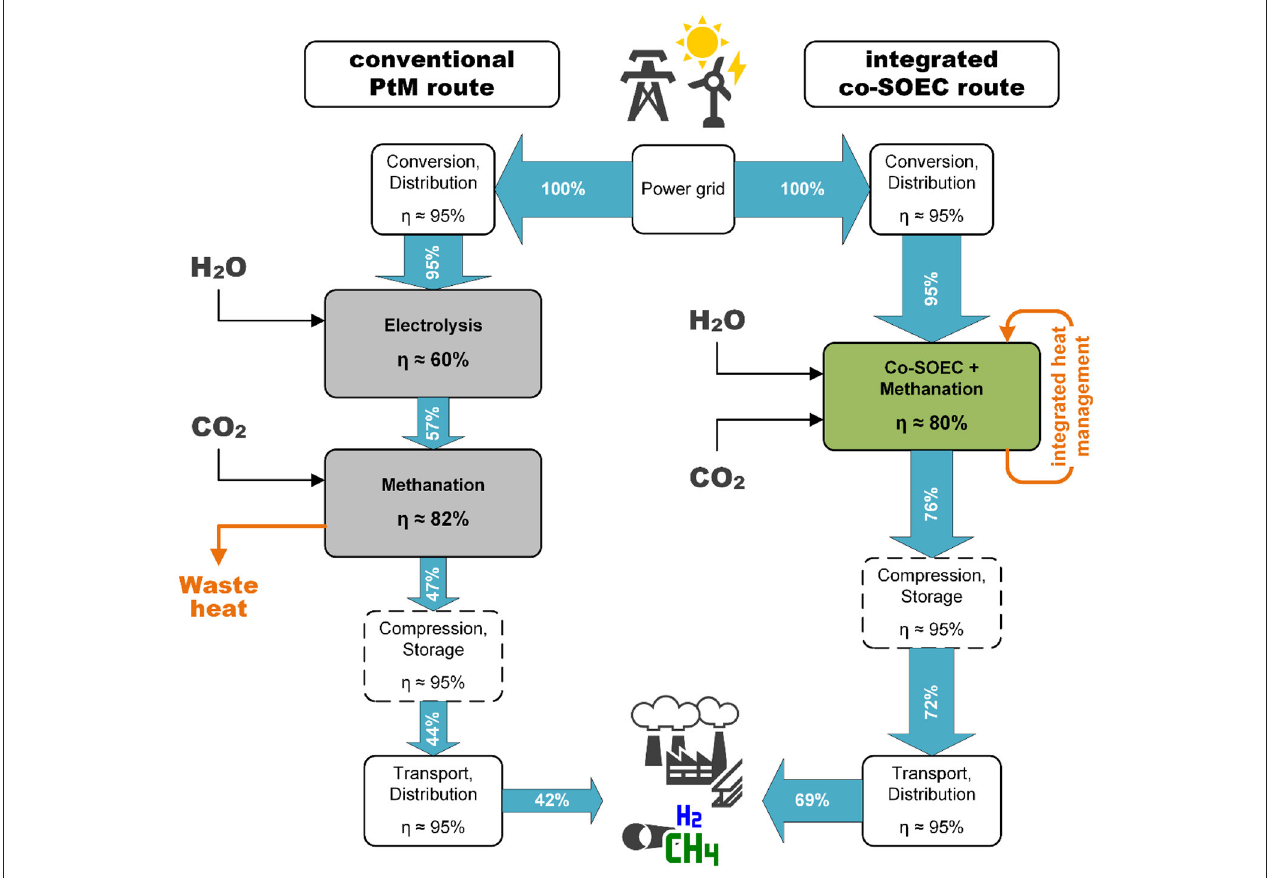
FIGURE 1 | Comparison of efficiency chains of power-to-methane routes using conventional technologies vs. the thermally integrated co-electrolysis